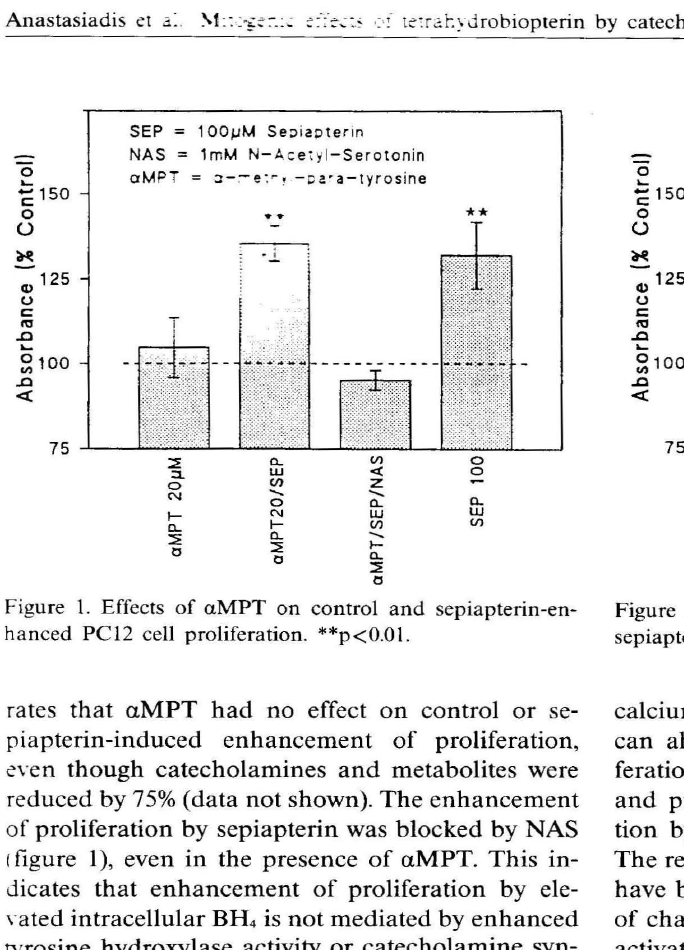
calcium metabolism. Finally, a nuclear role for